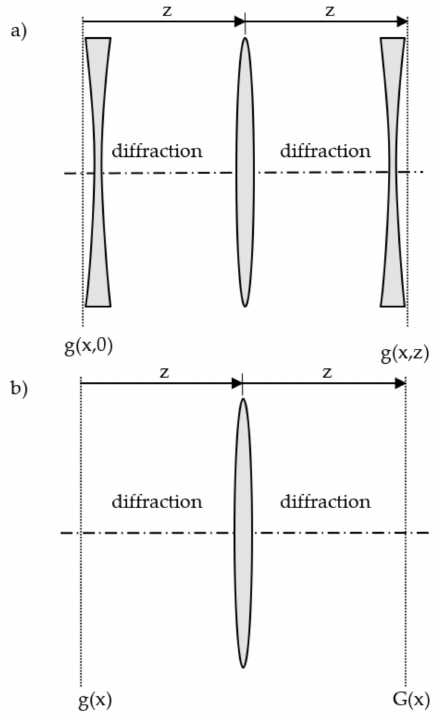
Figure 3. Additional ways to optical implement the two transforms of Figure 2: ( a ) Fresnel trans- form using three spherical lenses, i.e., two identical divergent lenses with focal length − z and one convergent lens with focal length z . ( b ) FT using only one convergent lens with focal length z